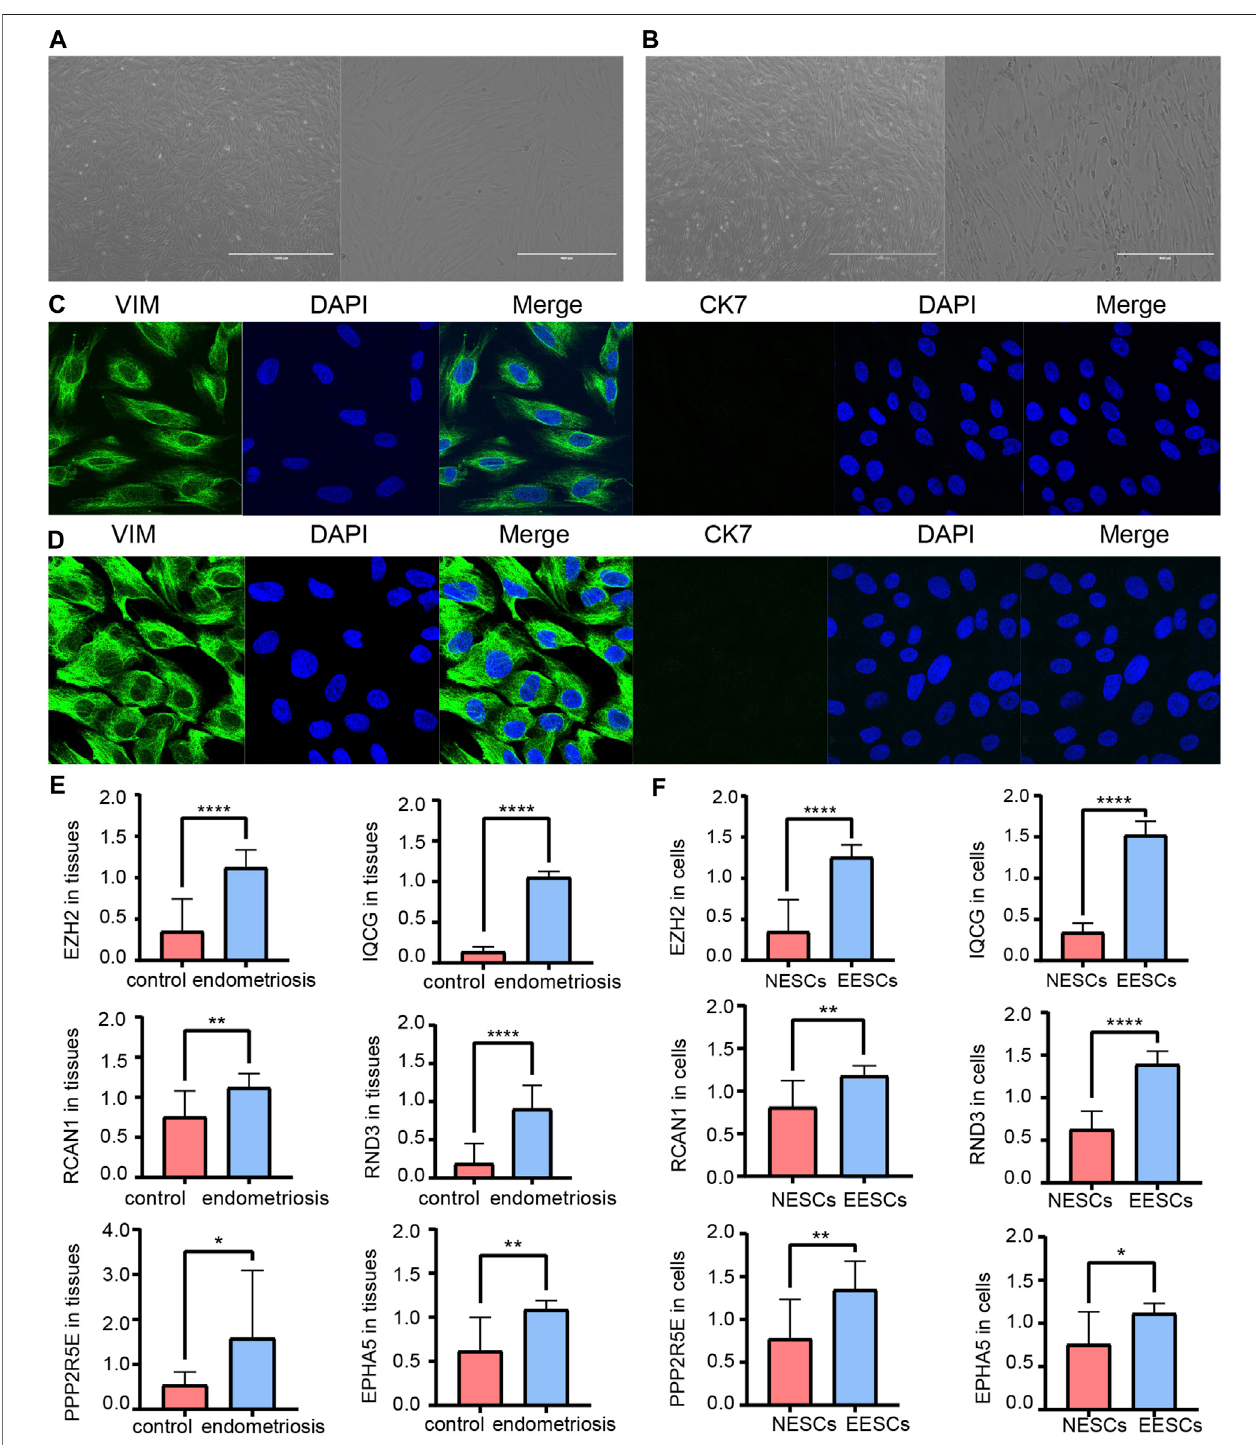
FIGURE 7 | Morphology of primary NESCs aggregates (A) . Morphology of primary EESCs aggregates (B) . Identi fi cation of primary NESCs (C) . Identi fi cation of primaryEESCs (D) .ThedifferencesintheexpressionlevelsofEZH2,IQCG,RCAN1,RND3,PPP2R5E,andEPHA5byRT-qPCRbetweentheendometriosistissuesand the control tissues (E) , those between NESCs and EESCs (F)